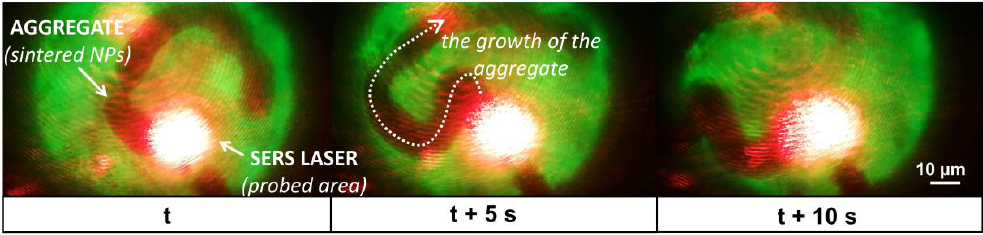
Figure 4. Microscopic observations of the development of a laser-induced aggregate within 10 s.